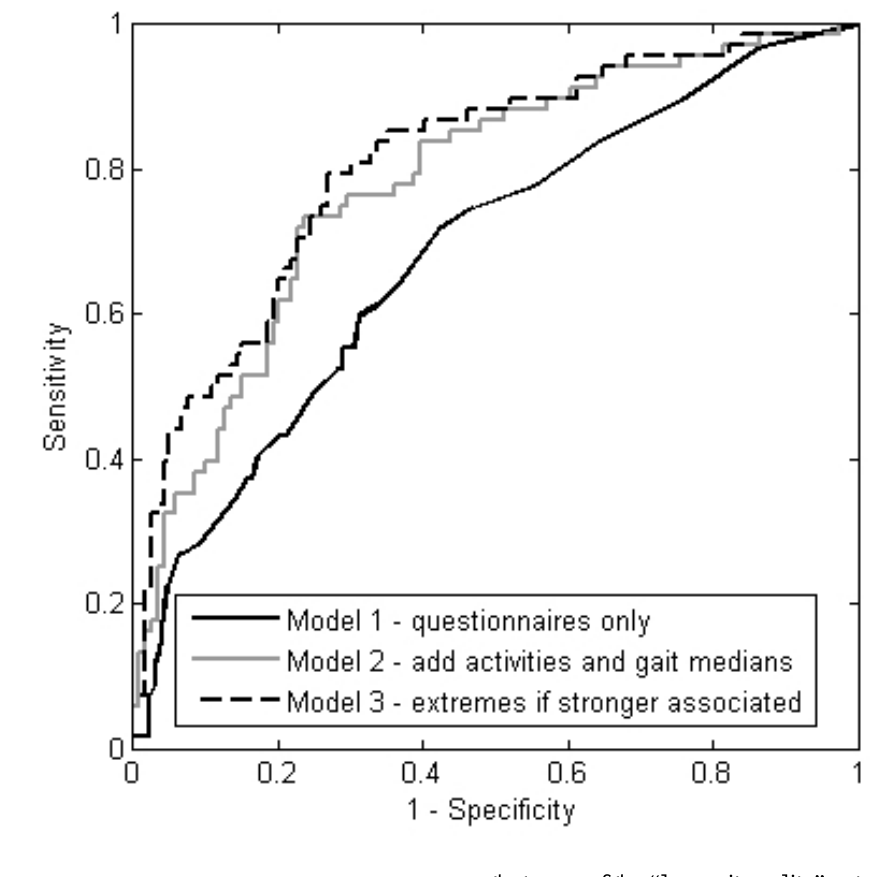
Figure 1. ROC curves for the 3 prediction